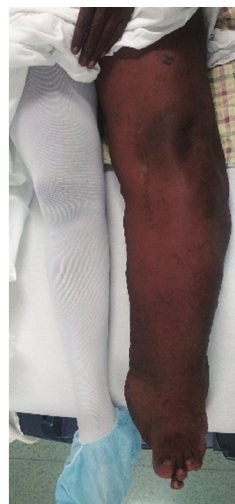
Figure 1: Patient has visible deformity and lymphedema of left leg.